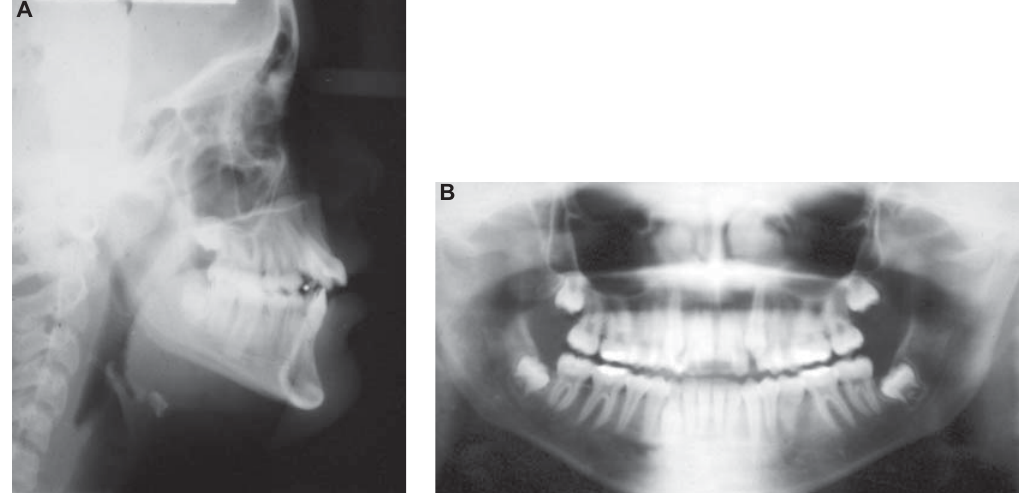
Figure 2- Initial lateral cephalograms (A) and panoramic radiograph